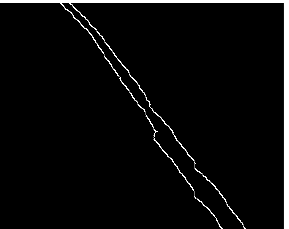
Figure 8. Image after applying all the